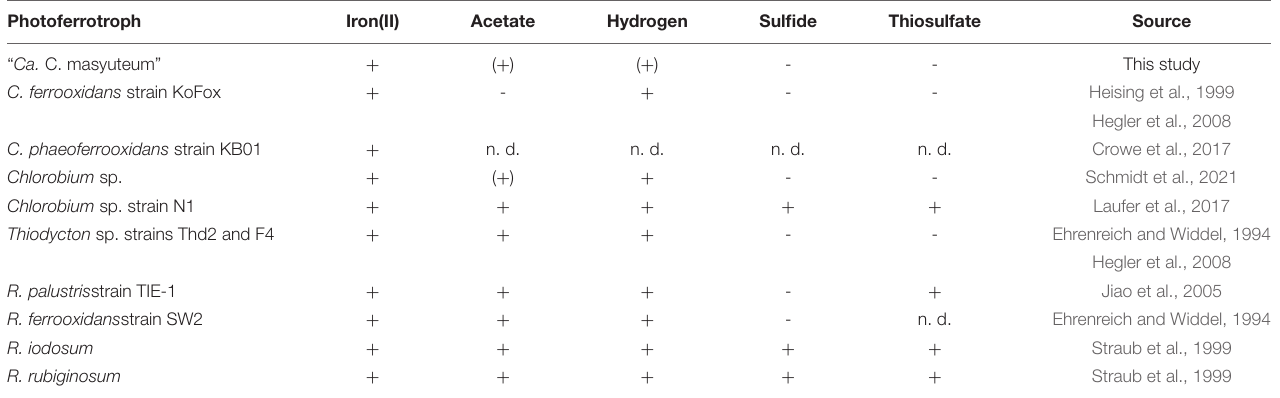
TABLE 1 | Commonly used sole organic and inorganic electron donors to assess additional photoautotrophic growth of true photoferrotrophic isolates or enrichments.